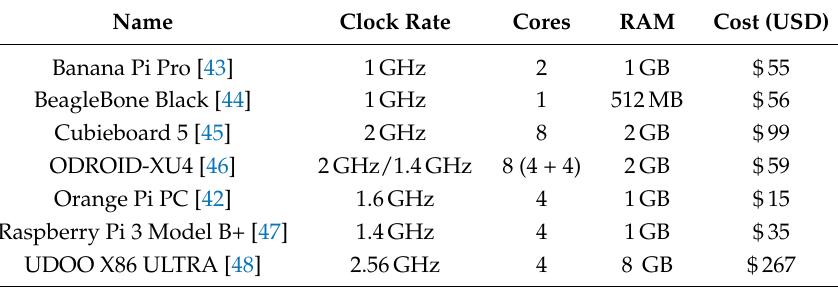
Table 1. Characteristics of some of the latest and most relevant